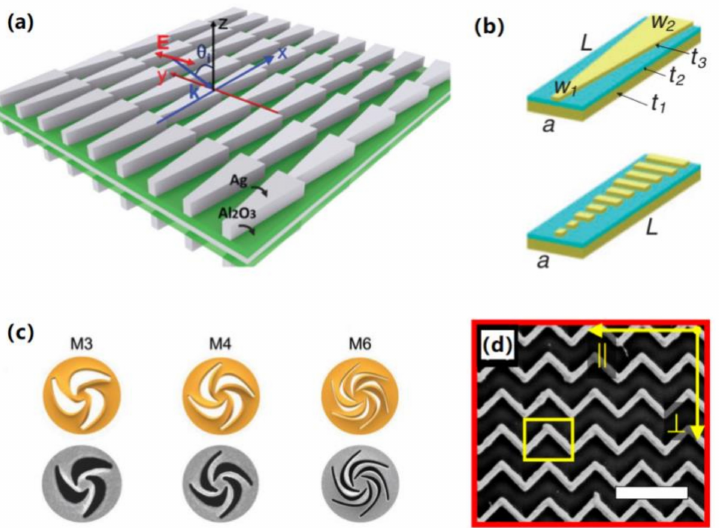
Figure 14. Typical examples of metasurfaces constructed by continuous or quasi-continuous meta- molecules, such as ( a ) trapezoids ( b ) that be regarded as combined rods with varied widths, ( c ) crescents and ( d ) zigzags array—( a – d ) are reproduced with permissions from references [169,188] (Copyright (2014) The Japanese Society of Applied Physics), [190,193]